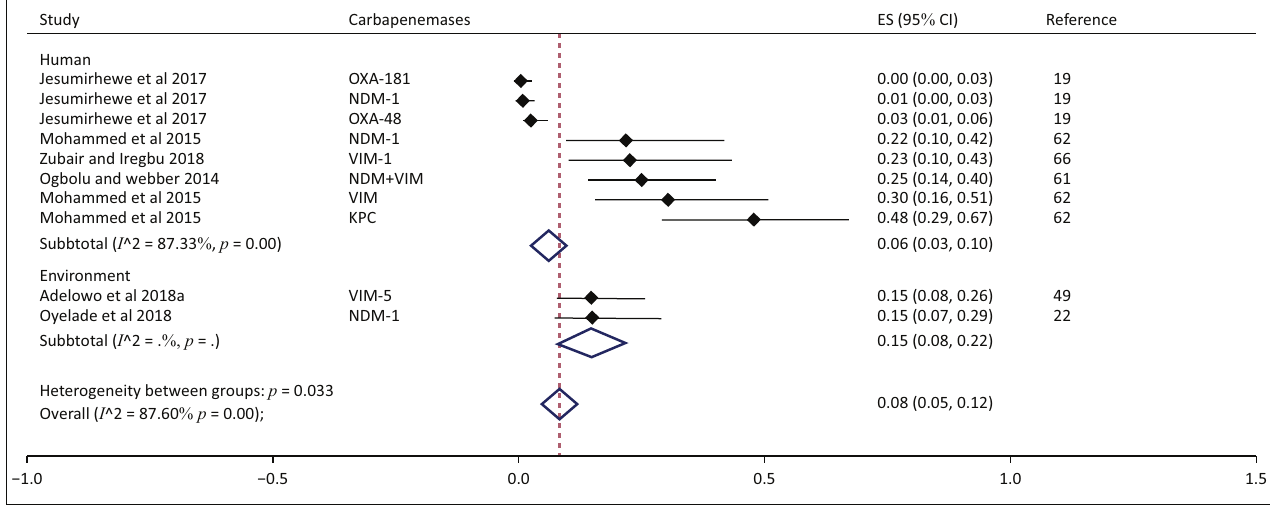
Note: Midpoint of each horizontal line segment shows the proportion estimate of carbapenemase resistance genes in each study. Diamond sign represents the pooled proportion from all studies included in the random-effect meta-analysis. P -values generated using STATA SE version 15.0 and does not represent exact values. CI, confidence interval. FIGURE 5: Subgroup analysis and forest plot of proportion estimates of carbapenemase beta-lactamases for human and environmental settings in Nigeria